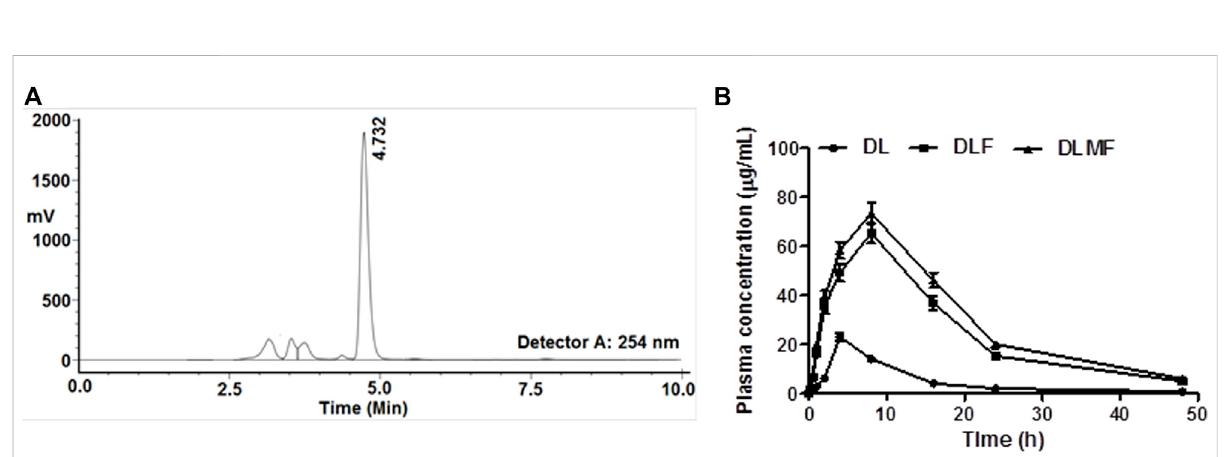
FIGURE 6 (A) Chromatogram of DL (RT 4.732 min) through HPLC, (B) Plasma drug concentrations at various time points after oral administration of DL, DLF and DLMF in albino Wistar